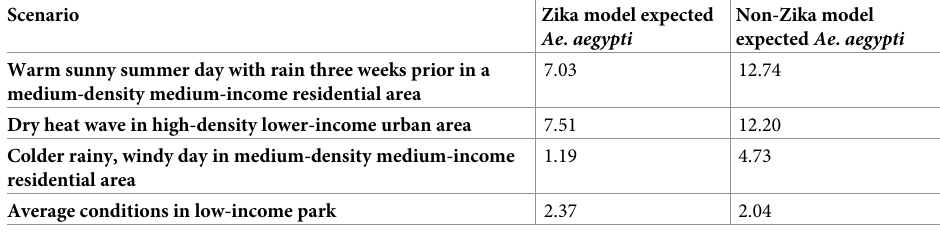
Table 4. Sample predictions for given model input conditions. Predictions were made using random forest models trained on data from traps located in regions affected by local transmission of Zika during the 2016 outbreak (“Zika model”) and unaffected regions (“Non-Zika model”). A full list of input parameters is included in the Methods